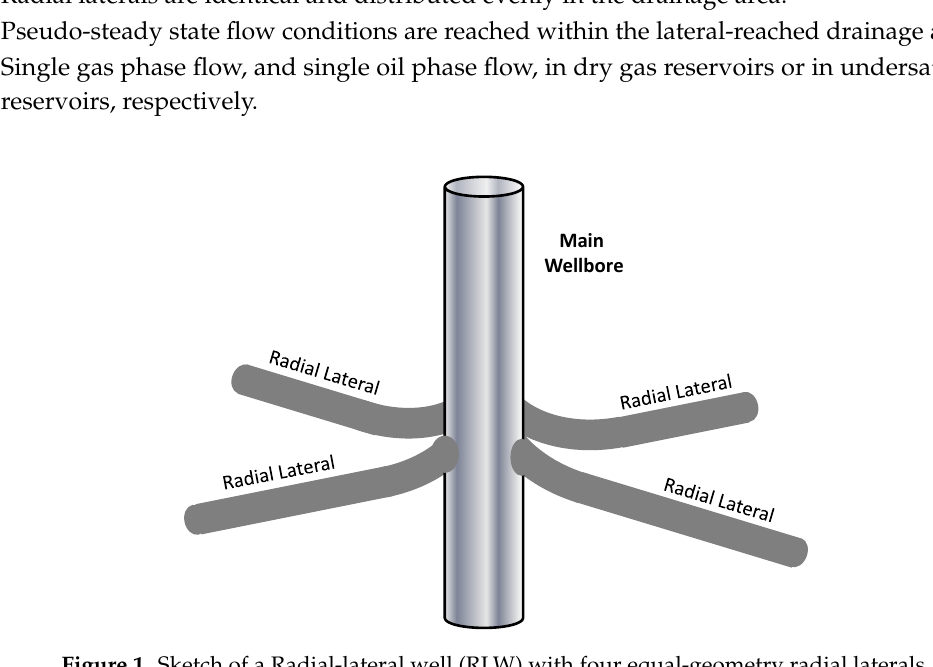
Figure 1. Sketch of a Radial-lateral well (RLW) with four equal-geometry radial laterals.